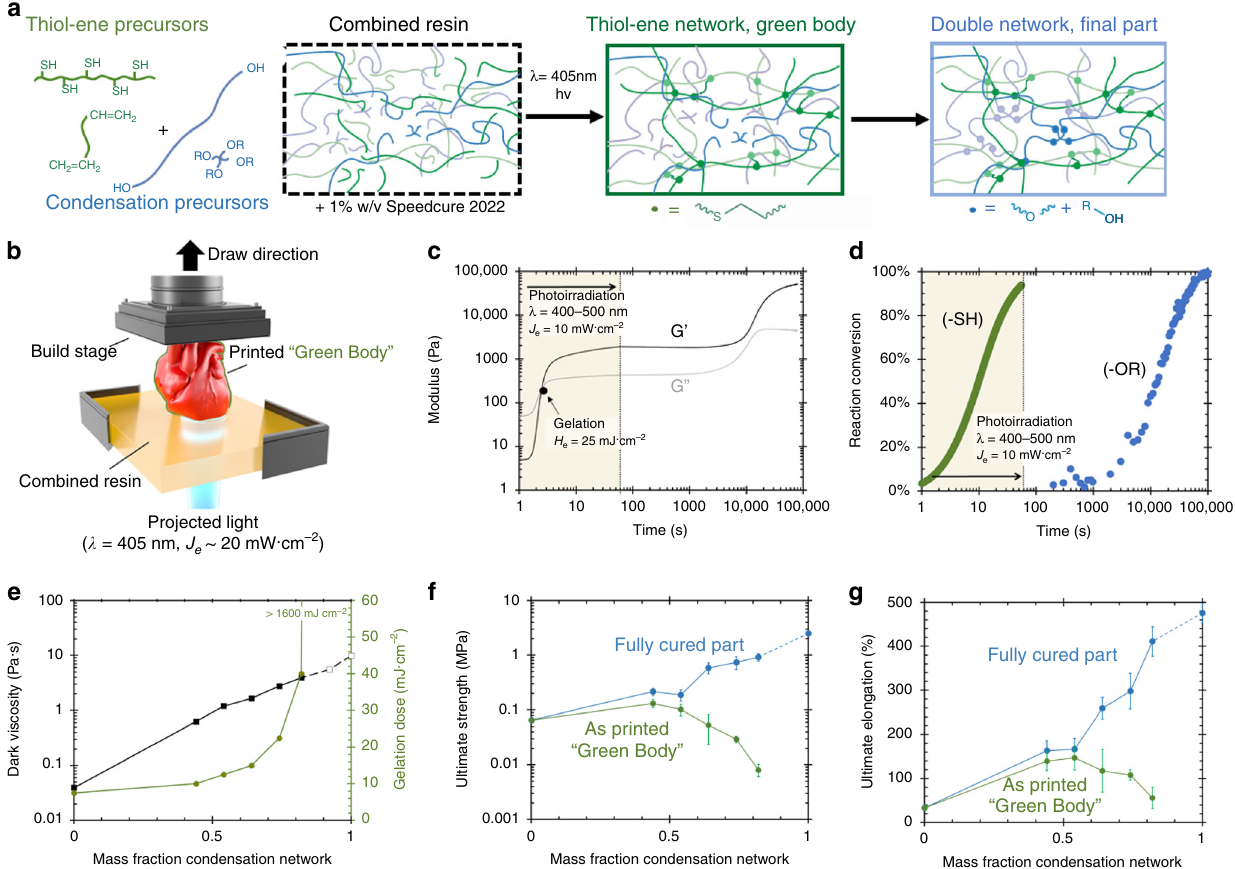
Fig. 1 3D printing double network silicones (SilDNs). a The precursors to a photocured thiol-ene silicone (green species) and a condensation silicone (blue species) combine to create the 3D printing resin. When exposed to light, the thiol-ene network crosslinks to form a green body that traps in the condensation components that slowly crosslink at room temperature to form the second network. These reactions are orthogonal and yield two distinct networks that occupy the same volume. b A schematic overview of the stereolithography (SLA) printing process. c , d The 82%MM10T resin ’ s rheological behavior ( c ) and the chemical conversion of crosslinkable groups (green circles denote thiol groups; blue circles denote alkoxy groups) ( d ) shows the independent development of the two networks during the printing process. e The dark viscosity (black line) and gelation dose (green line) of SilDN resins as a function of the relative mass fraction of the two networks. Open symbols denote compositions that are unprintable ( N = 3). f , g Ultimate strength ( f ) and elongation ( g ) in the as-printed green body (green line) and fi nal part (blue line) as a function of mass fraction of the two networks. Error bars represent the SD in measured values ( N >